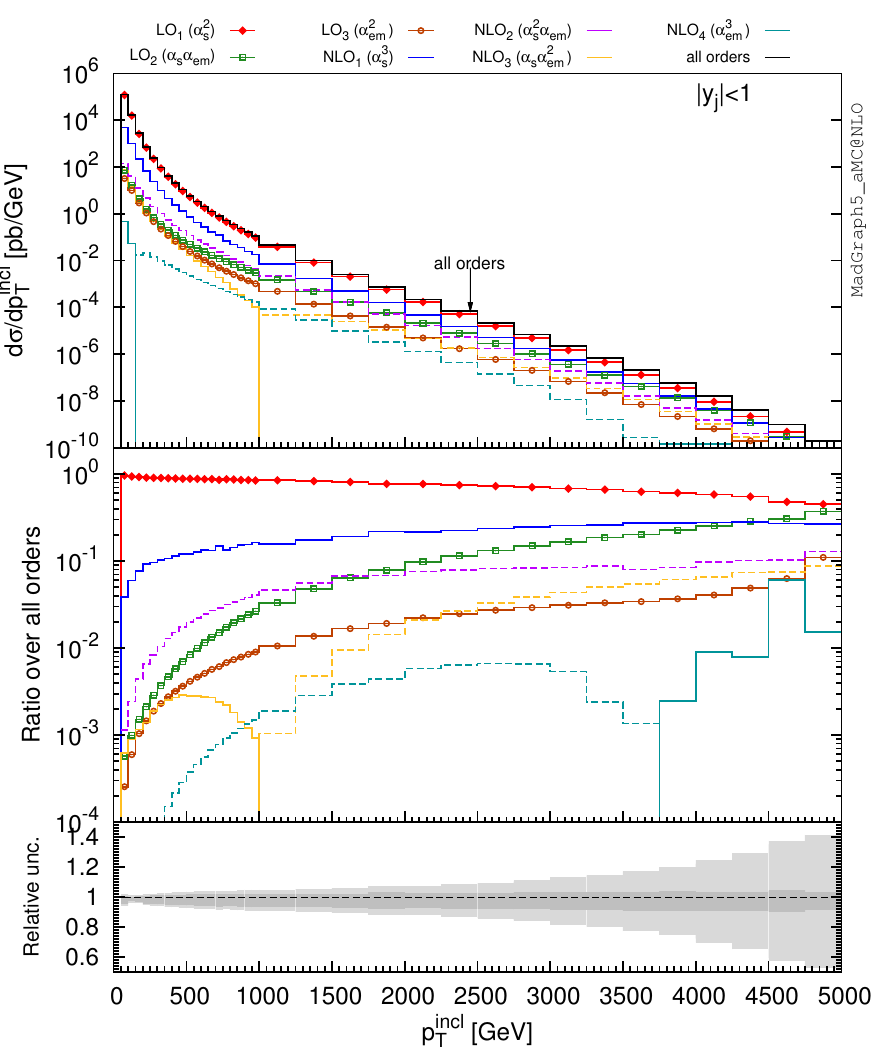
Figure 4 . Single-inclusive transverse momentum, for j y j (cid:20)